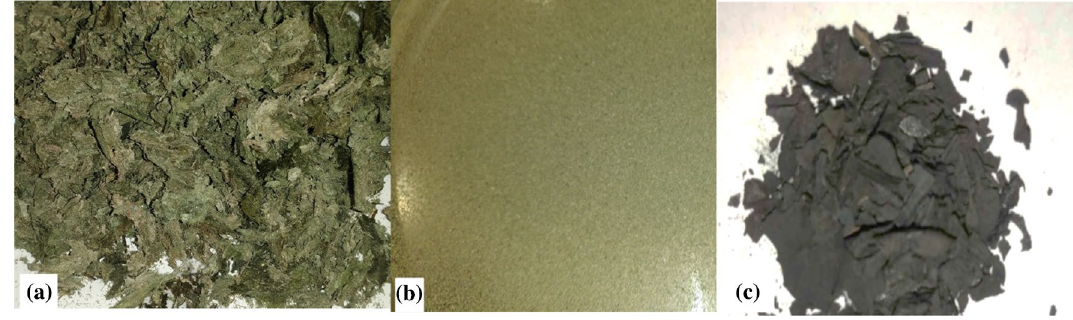
Fig. 1 Ricinus communis leaves a before grinding and sieving, b after grinding and sieving and c after activation by